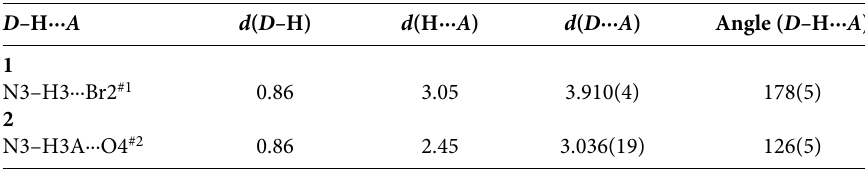
Table 3. Hydrogen bond distances (Å) and bond angles (deg) for the